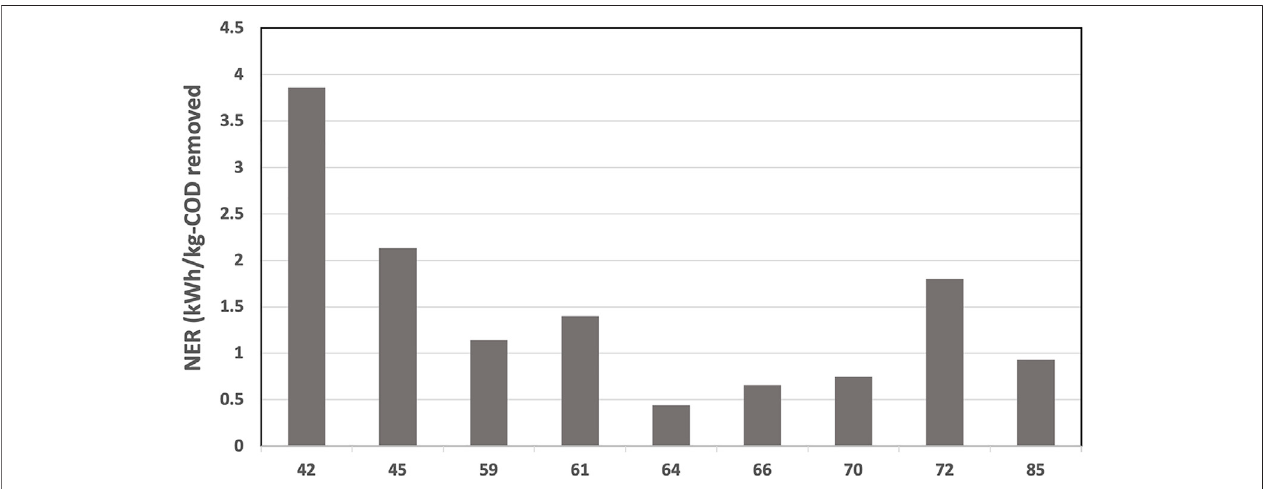
FIGURE 8 | NER estimated for BETT Demo